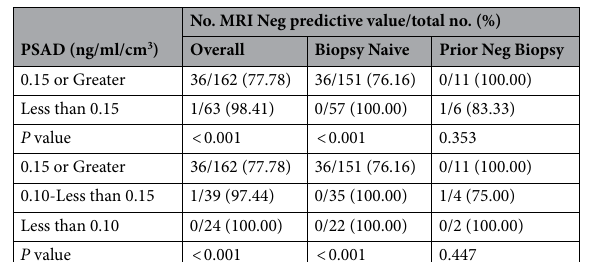
PSAD (ng/ml/cm 3